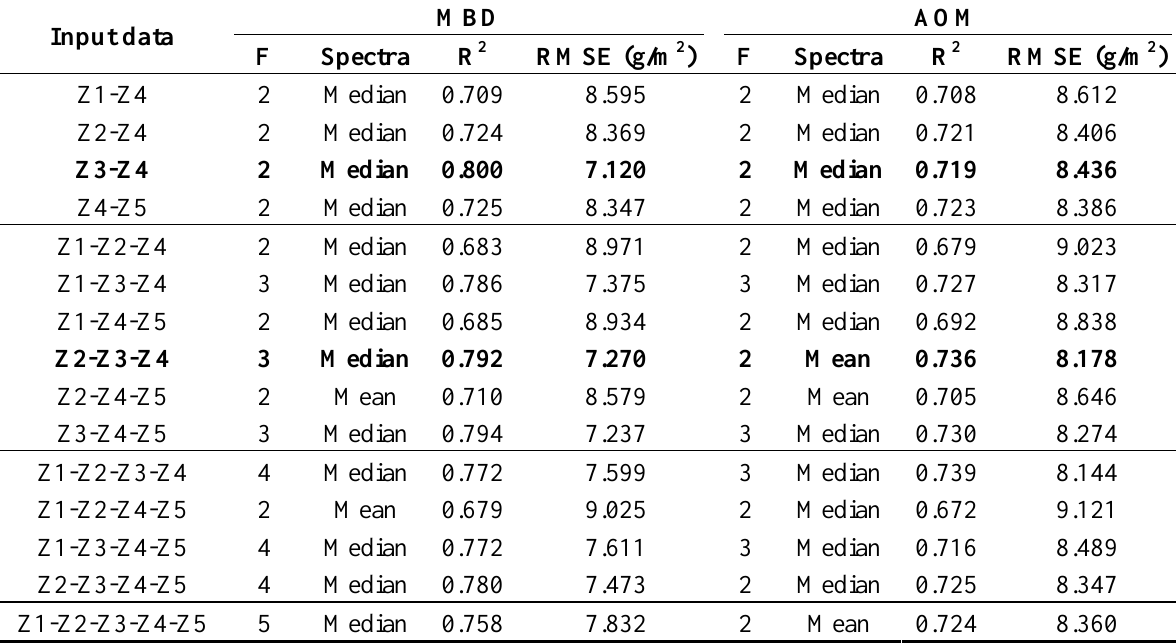
Table 8. Performance of PLSR for predicting total (TAGB) grass/clover biomass using indices which consider the absorption feature Z4 derived from the continuum removed spectra. In bold: most accurate